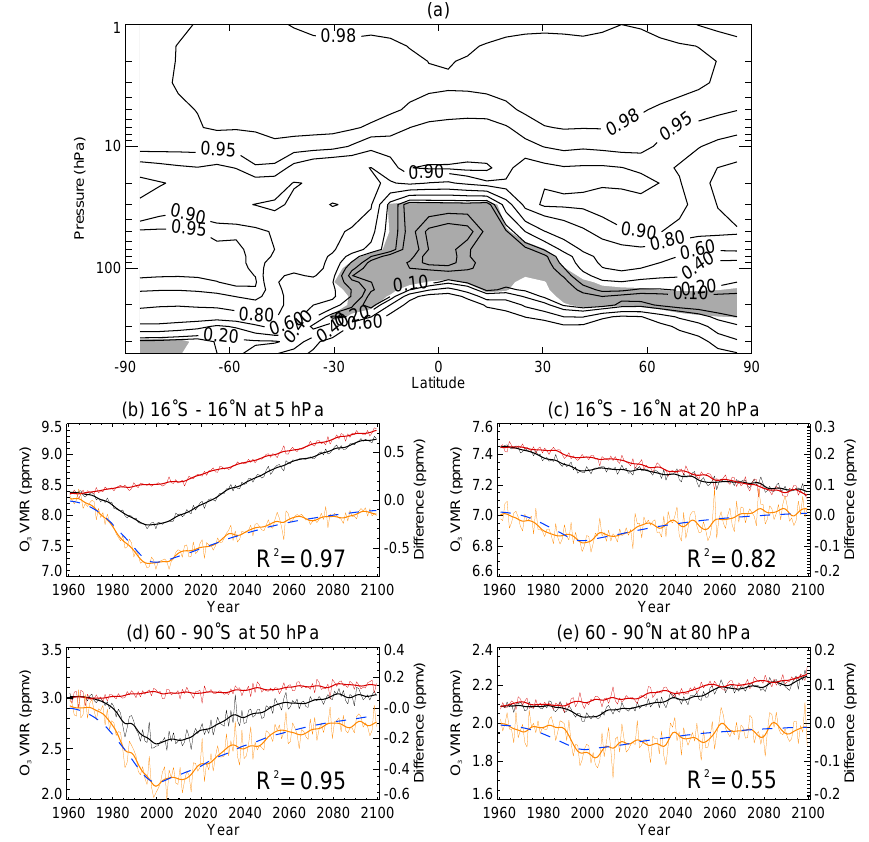
Fig. 3. (a) presents the coefficient of determination from the fit of the smoothed (REF-B2–GHG) ozone timeseries to EESC. Shading denotes regions where the difference between the REF-B2 and GHG runs for 1990–2009 average ozone was not statistically significant at the 95% level. (b) through (e) present timeseries of the ensemble average ozone mixing ratio from the REF-B2 (black line) and GHG (red line) runs averaged over 16 ◦ S–16 ◦ N at 5hPa (b) , 16 ◦ S–16 ◦ N at 20hPa (c) , 60–90 ◦ S at 50hPa (d) and 60–90 ◦ N at 80hPa (e) . The orange solid line is the difference (REF-B2–GHG) in ozone and the blue dashed line the result of fitting the difference to the local EESC timeseries. All ozone timeseries display both the original annual averages (thin line) and the series after smoothing with a Gaussian filter with a width of 4 years (thick